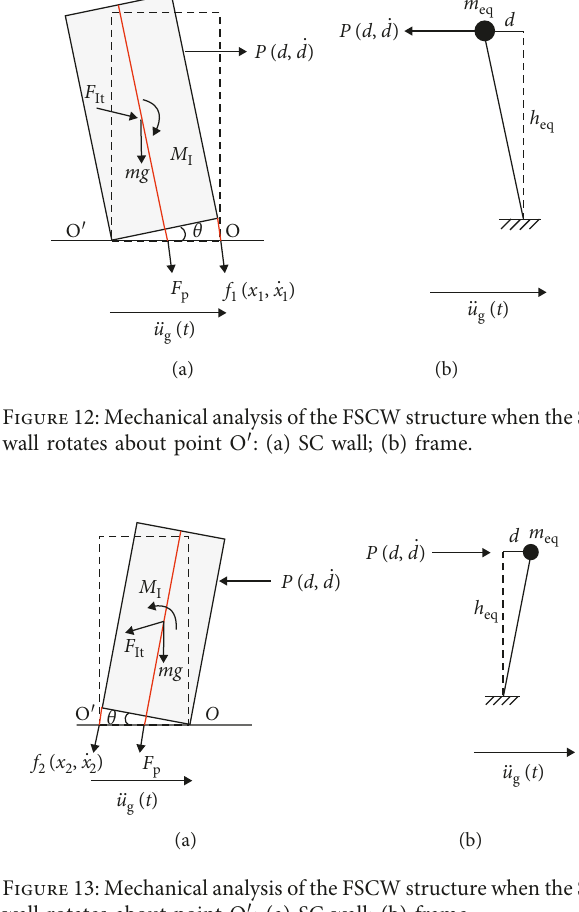
Figure 13: Mechanical analysis of the FSCW structure when the SC wall rotates about point O : (a) SC wall; (b) ′